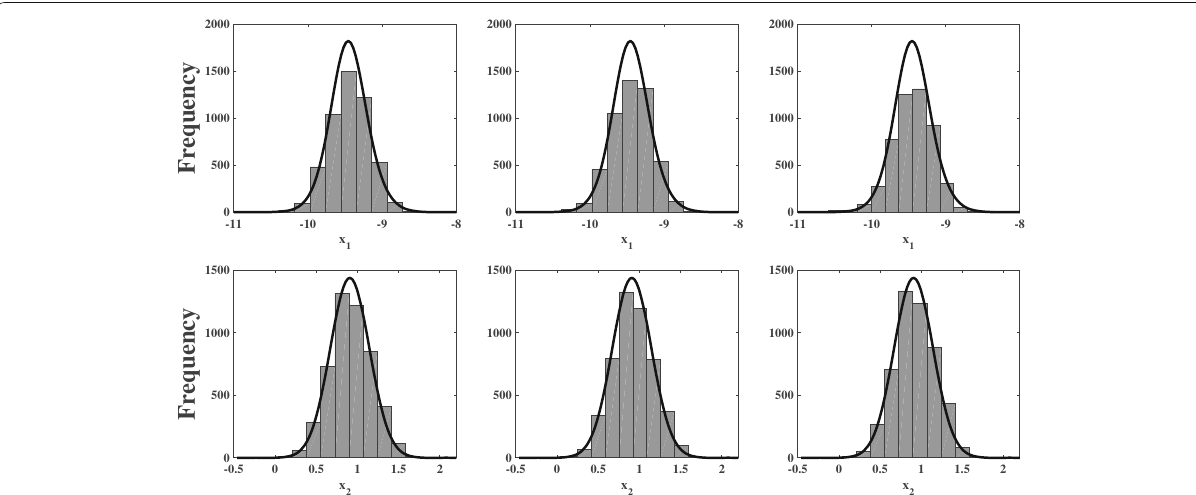
Fig. 4 Univariate frequency histograms of x n ,1 (top row) and x n ,2 (bottom row) in Example 1 in the case of filtering at n = T . The non-normality (asymmetries) of the frequency histograms is well approximated by the fitted GMM (solid line). The histograms are constructed using resamples (cid:4) (cid:3) M , w i from x i T T i = 1